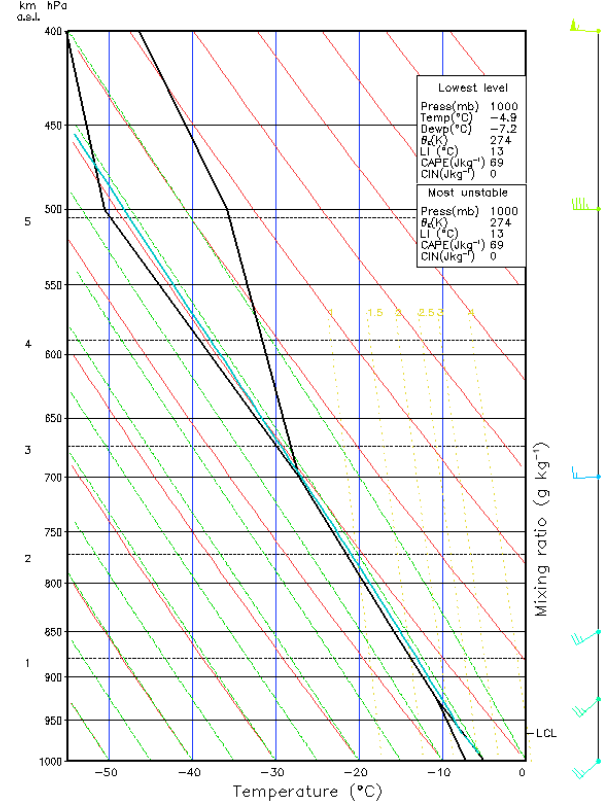
Figure 5. A thermodynamic diagram taken over the sea at 62 ◦ N, 21 ◦ E (see Fig. 1) at 13:00UTC from 1000 to 400hPa. Height (in km and in hPa, dashed and solid black horizontal lines, respec- tively) is shown in the left vertical axis, temperature (blue) in the horizontal axis, and mixing ratio (yellow) in the right vertical axis. Wind barbs are shown on the right. Other contours shown are dry adiabats (red), moist pseudo-adiabats (green), simulated tempera- ture and dew point soundings (black), and a parcel path from the most unstable level upward (light blue). Thermodynamic indices for surface (1000hPa) and the most unstable level are shown in the top right boxes. The 2m temperature was − 4 ◦ C and the sea level air pressure